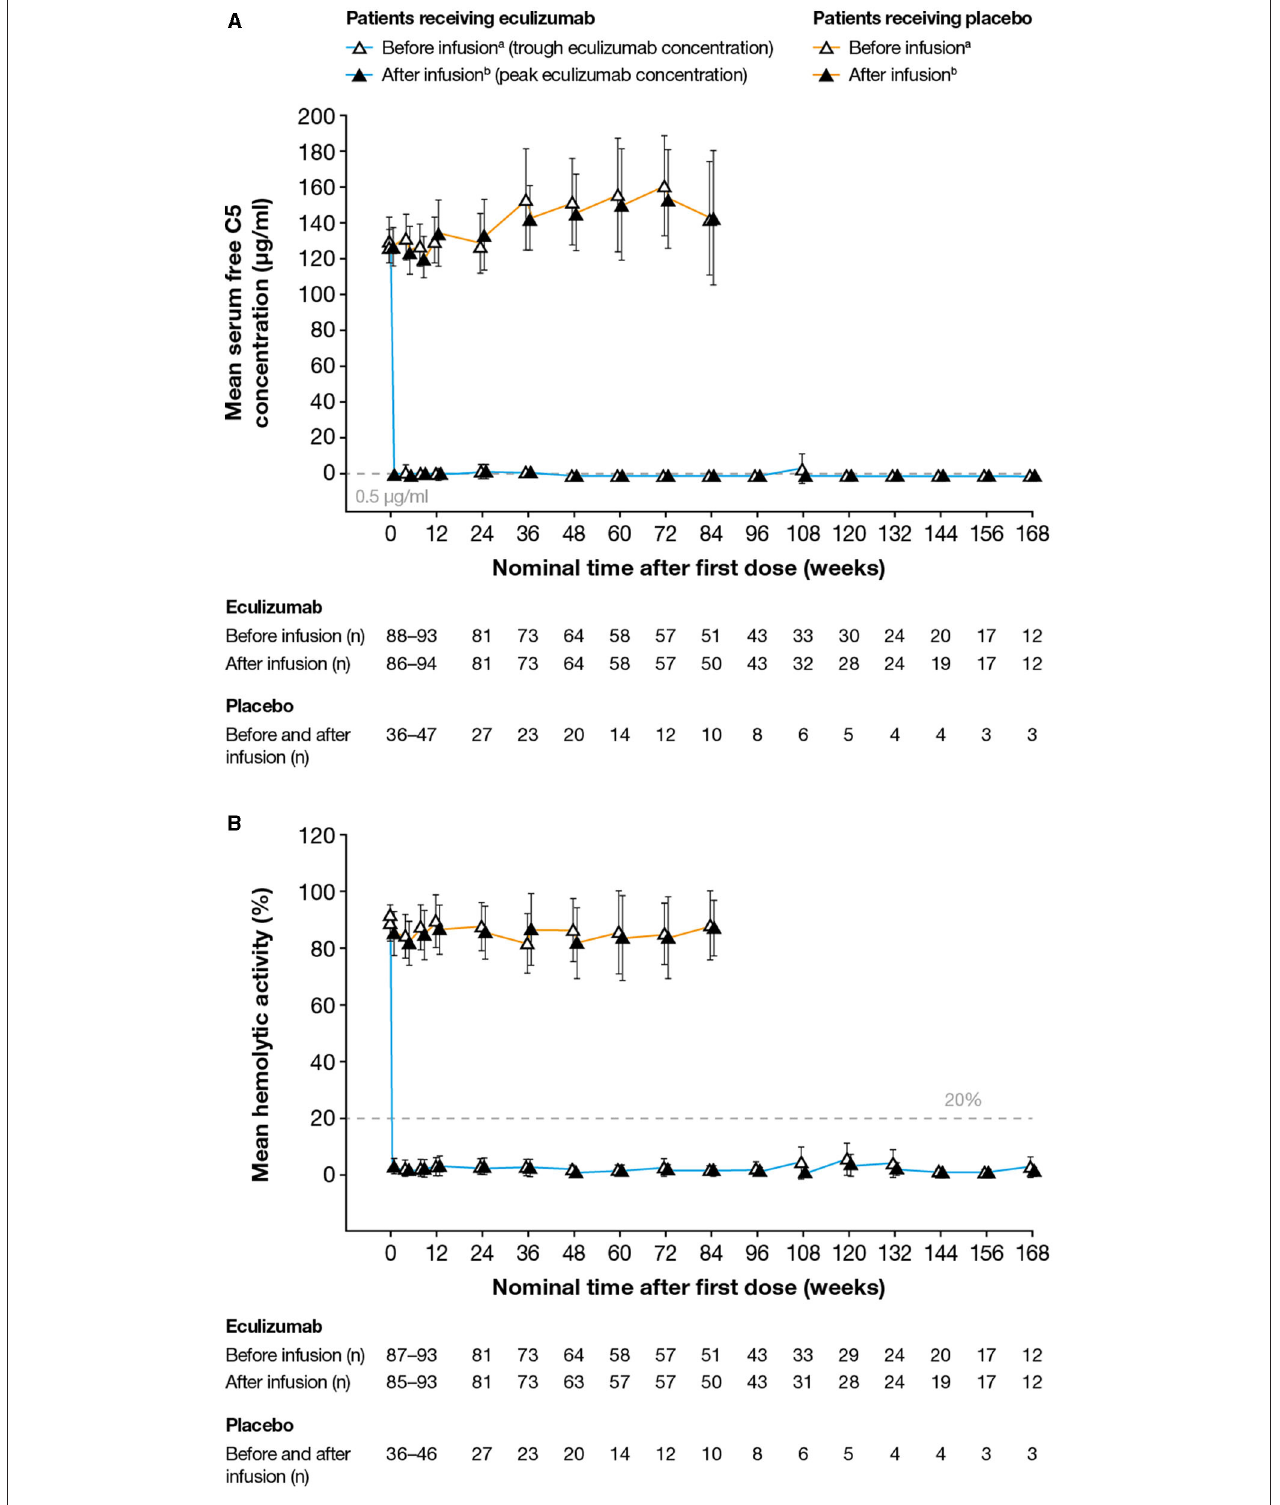
FIGURE 3 | Serum free C5 concentrations and complement-mediated hemolytic activity in serum during the study. (A) Mean (95% CI) serum free C5 concentrations. Free C5 concentrations below the lower limit of quantification (0.0274 µ g/ml) were analyzed as 0.0137 µ g/ml (half the lower limit of quantification). Free